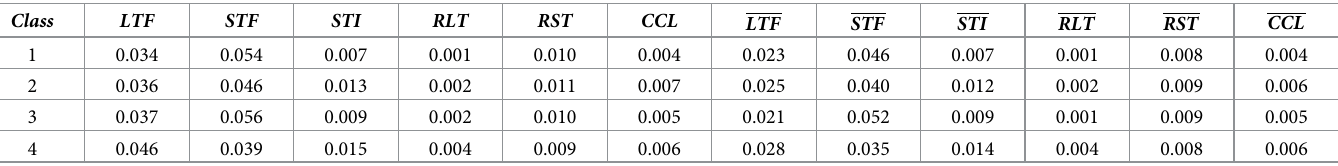
Table 10. Comparison of the average gap AvG for all algorithms according to the different classes class